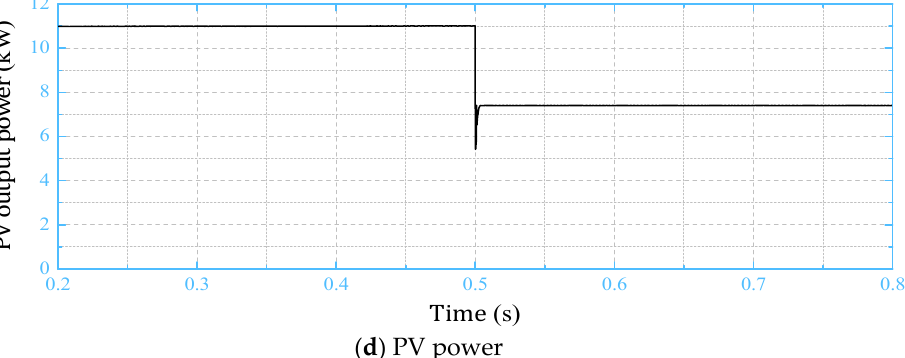
Figure 7. The PV panel current, voltage, and power.